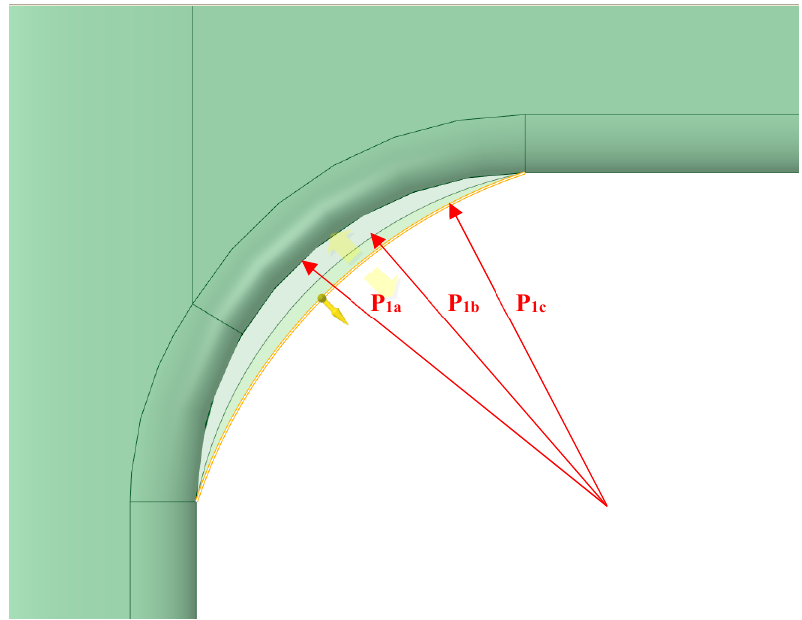
Figure 16. Example of how radius P1 evolves from P1a to P1c during the response surface optimization.